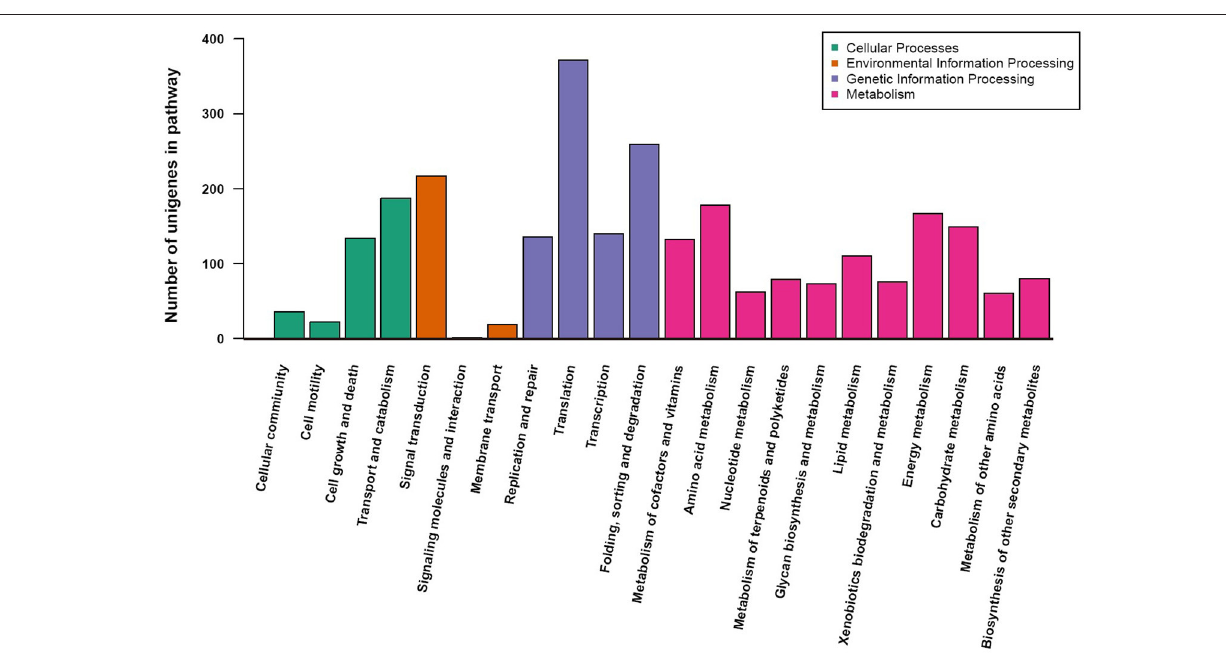
(259 unigenes; 9.6%), and Signal transduction (217 unigenes;